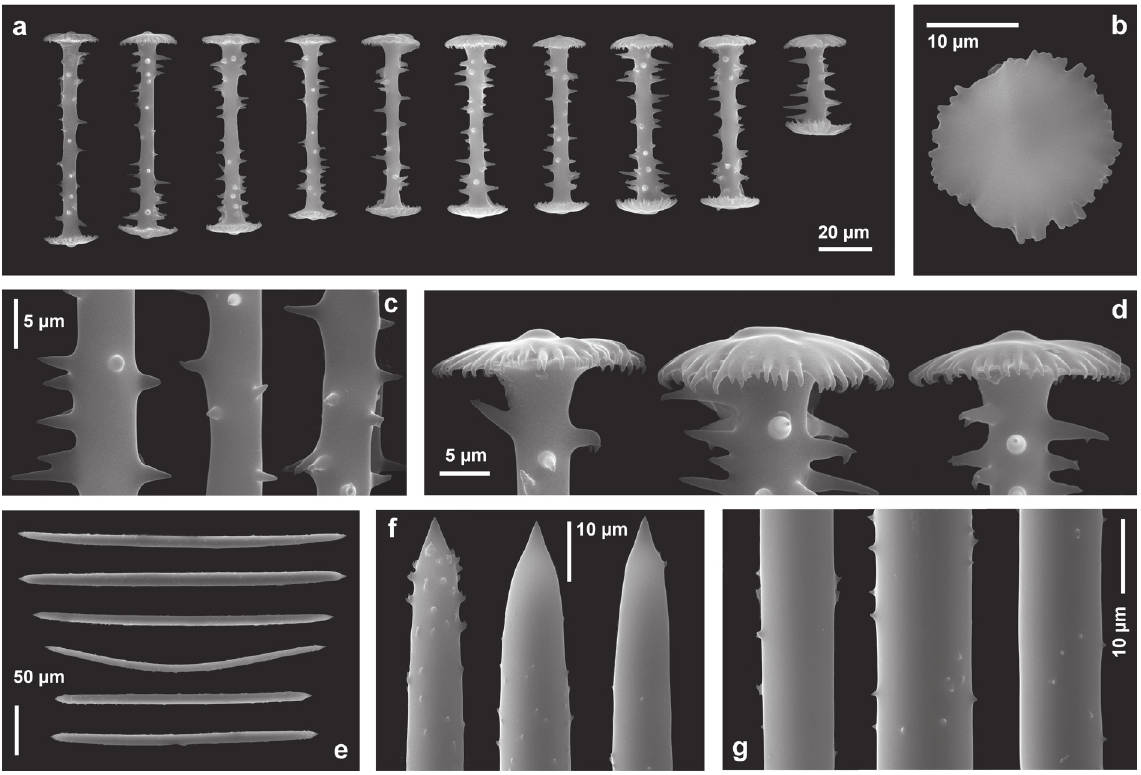
Fig. 5. Umborotula bogorensis (Weber, 1890) from the Sakaerat Biosphere Reserve, NE Thailand. Spicular complement (SEM) of gemmules and skeleton. a . Gemmulosclere birotules armed by large spines. b . Rotule of a gemmulosclere (top view). c . Shafts of gemmuloscleres with large scattered spines. d . Rotules of gemmulosclere (lateral view). e . Megascleres (oxeas) of the skeleton. f . Megascleres, tips. g . Megascleres,